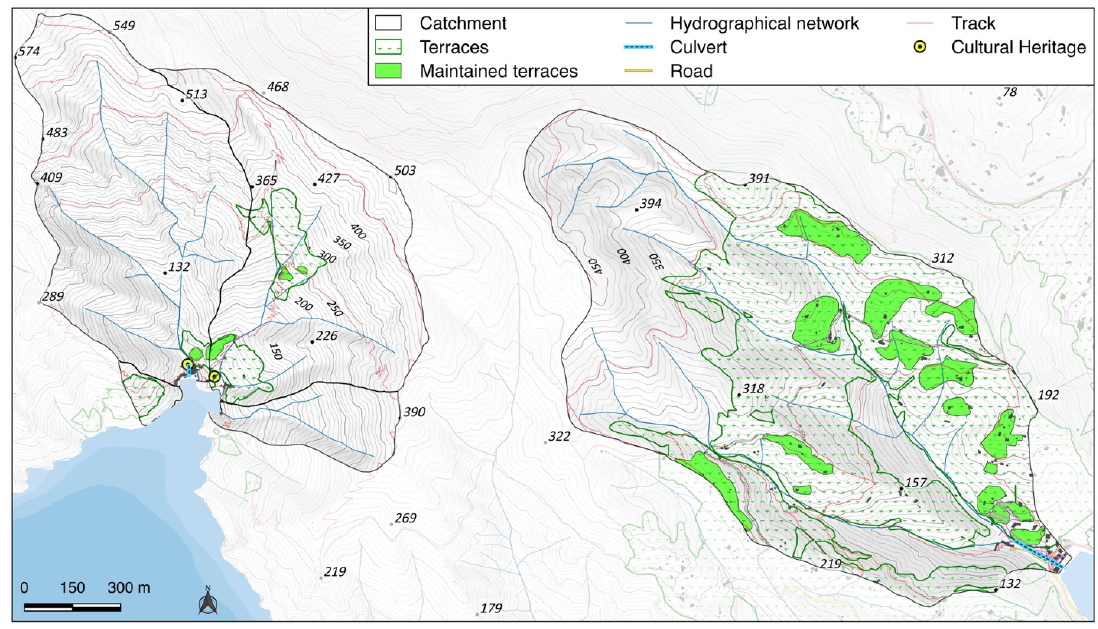
Figure 7. Terrace identification in the studied catchments after the application of the integrated methodology and evidence of the in use/maintained ones. Table 4. Terraced surface and the in use/maintained percentage for the studied catchments.